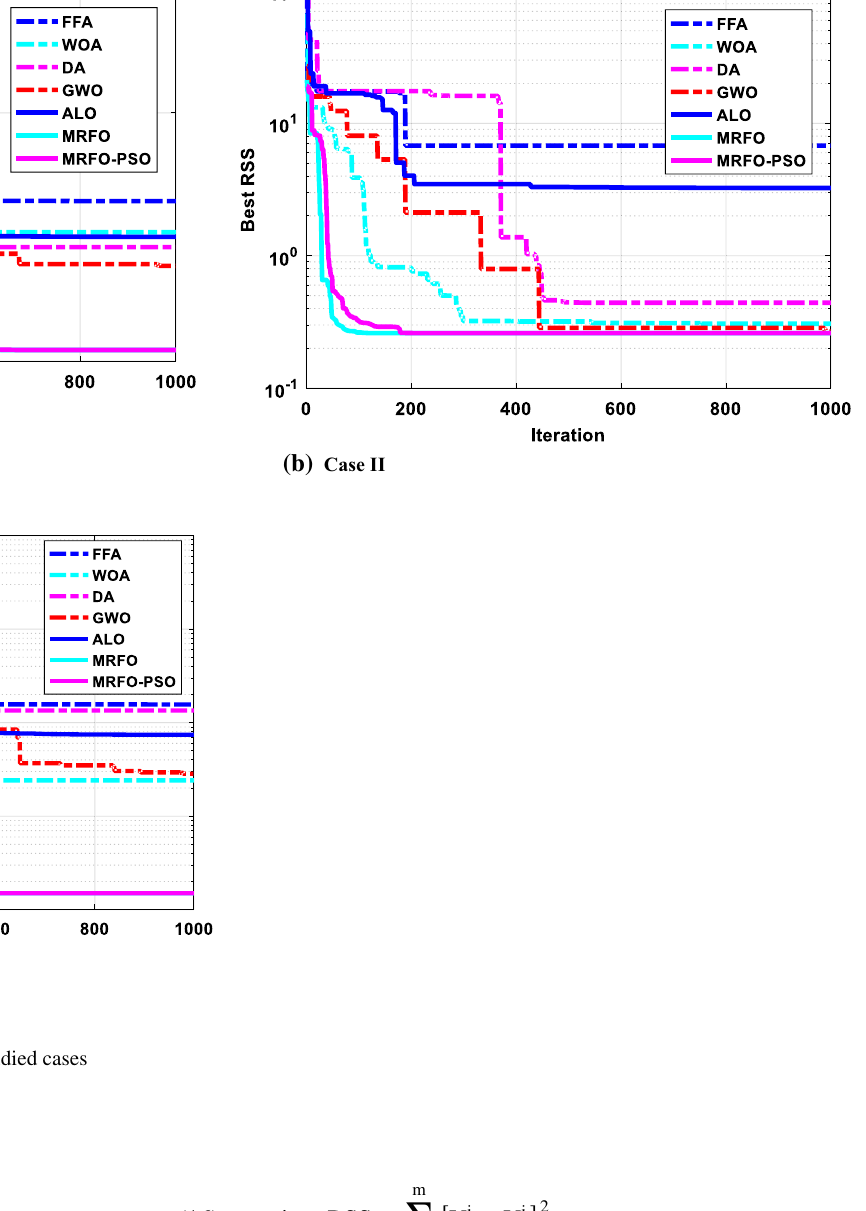
where V i s is the discharge voltage sampled from the datasheet curve, V i c is the calculated discharge voltage, and m is the number of sampled points in the datasheet curve. In this study, we used the samples points extracted by Yong Wang and Lin Li uploaded in an Excel file on (http:// bingh amton. edu/ seorl). For problem boundaries, we used their initial values X initial multiplied by 10 as the upper boundary, and 0 as the lower boundary for all cases [74]. In context, three cases are studied.